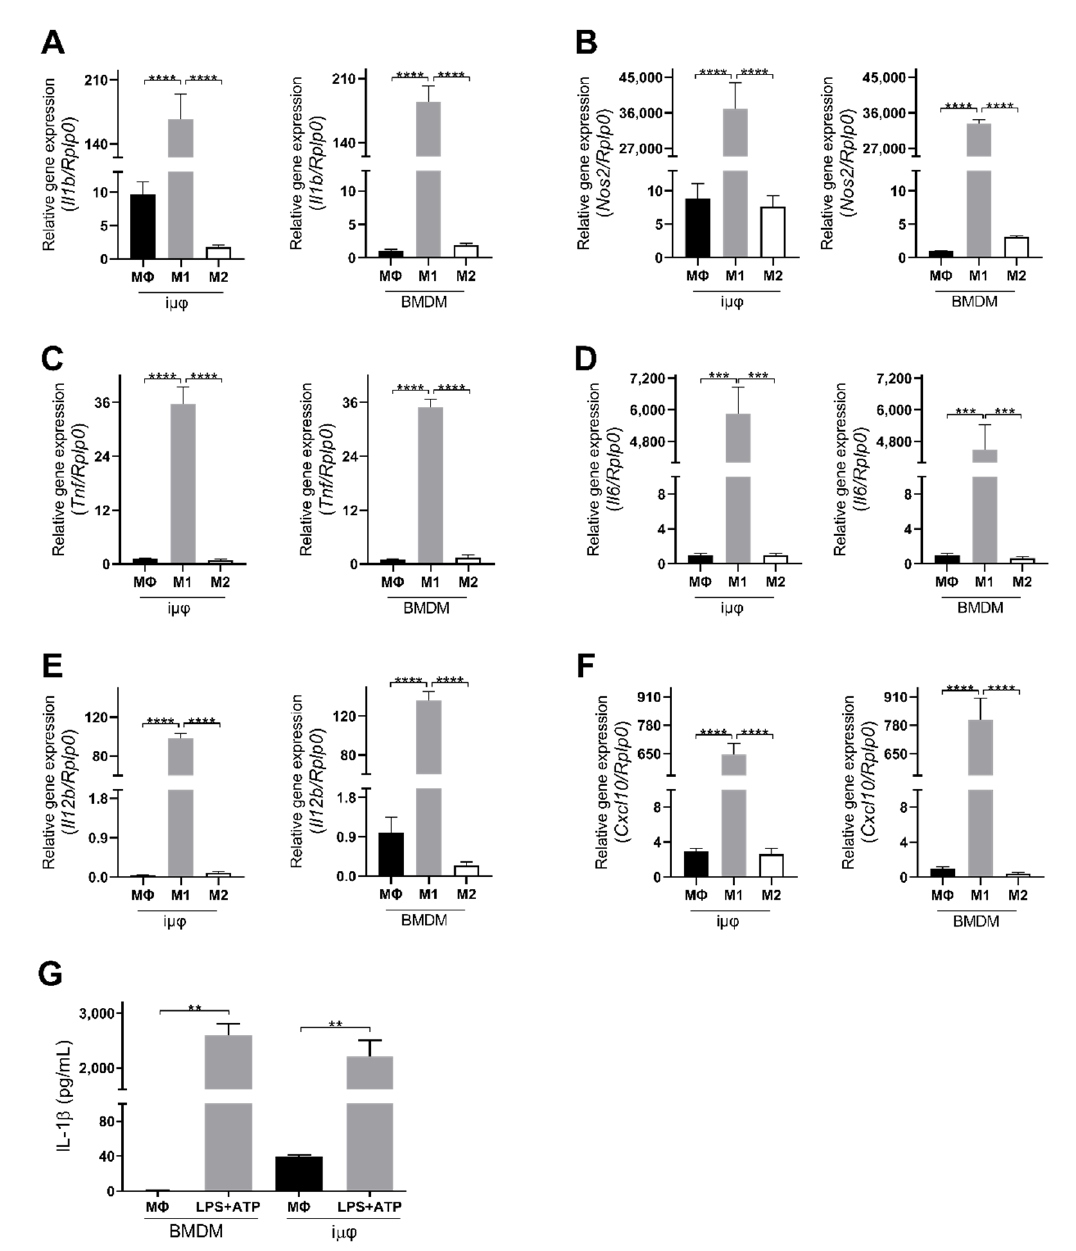
Figure 1. Classically (M1)-stimulated immortalized murine macrophages (iµФ) and BMDMs display similar phenotypical features. ( A – F ) qRT-PCR quantification of Il1b ( A ), Nos2 ( B ), Tnf ( C ), Il6 ( D ), Il12b ( E ), Cxcl10 ( F ), specific genes in resting (MΦ), M1- and M2-stimulated iµΦ macrophages ( n = 3) and in BMDM macrophages ( n = 3). ( G ) Levels of IL-1β release from LPS + ATP-stimulated iµΦ and BMDM macrophages. Data are means ± SEM. ** p < 0.01, *** p < 0.001, **** p < 0.0001.